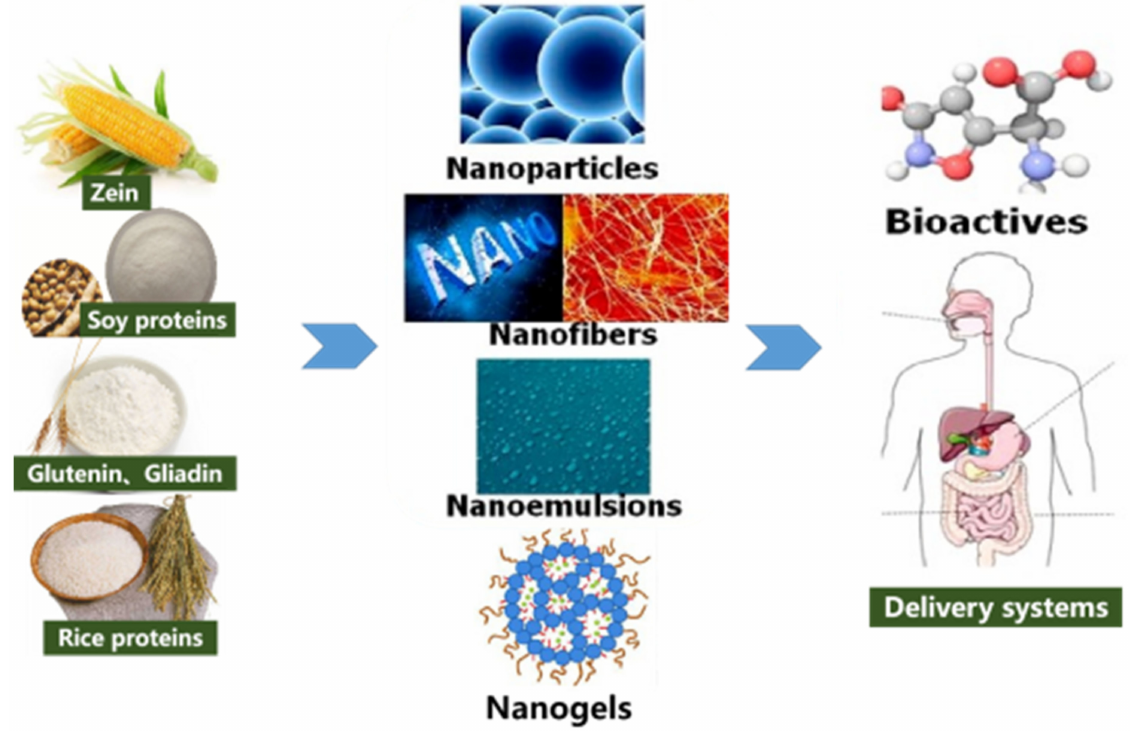
Figure 2. Nanostructured plant proteins: fabrication and applications as delivery systems for bioac- tives [40] (Reprinted with permission from Chuan-He Tang (2019). Copyright 2019